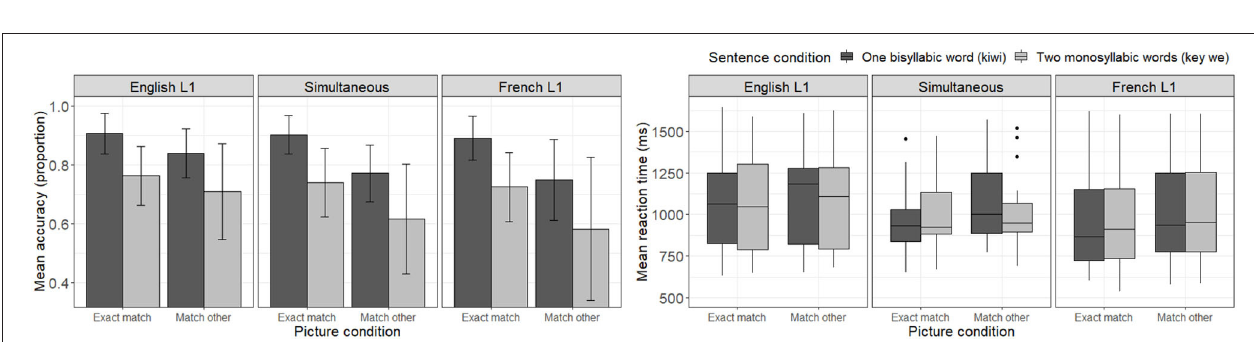
FIGURE 3 | Mean accuracy (left) and reaction time (ms) to correct response (right) to English trials as a function of sentence and picture conditions, as well as participants’ native